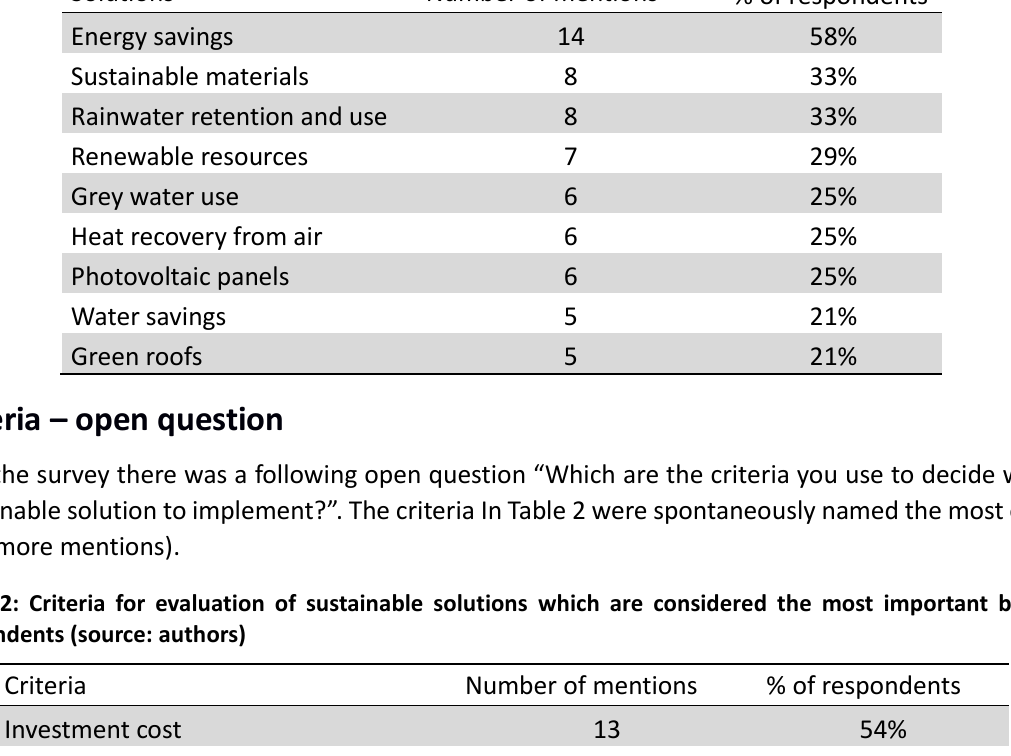
Table 1: Solutions which are considered a sustainable solution by the respondents (source: authors) Solutions